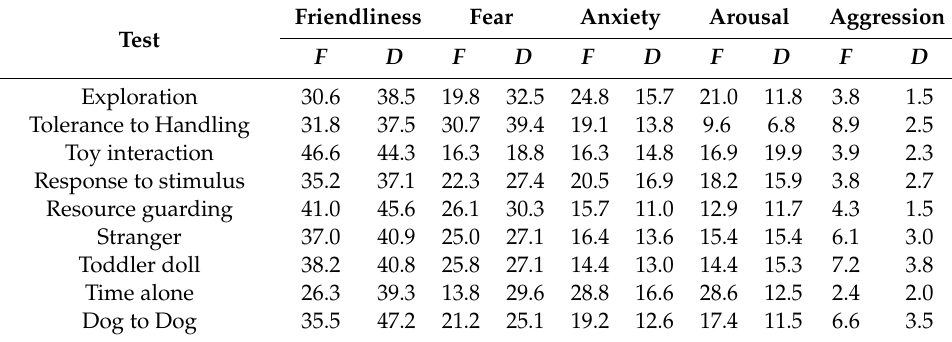
Table A3. Percentage of coded durations and frequencies of the five behavioural categories (friendliness, fear, anxiety, arousal and aggression) during each subtest in the standardised behaviour assessment.